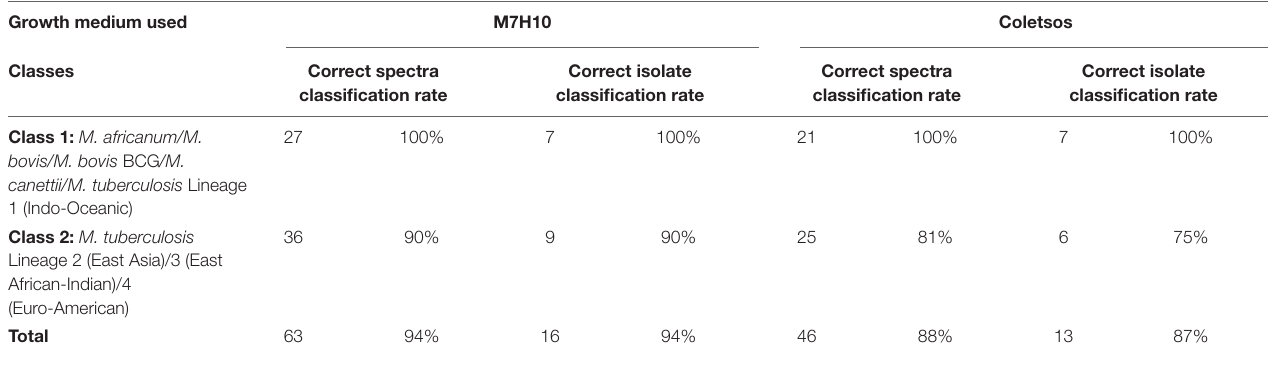
TABLE 6 | Correct classification rates for spectra and isolates from isolates grown on other culture media according to QC2. Growth medium used M7H10 Classes Correct spectra classification rate